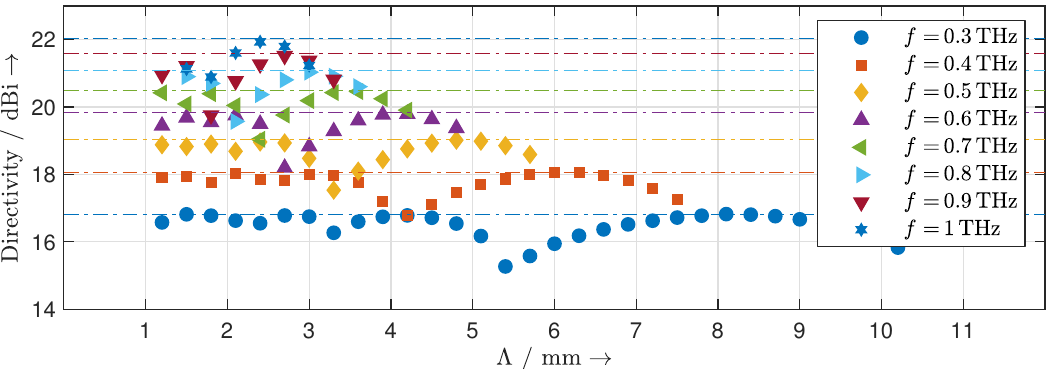
Figure 9. Directivity of the MEMS reflection gratings for different grating periods at different frequencies(solid points) and theoretical directivity of an equivalent uniform linear antenna array (dashed